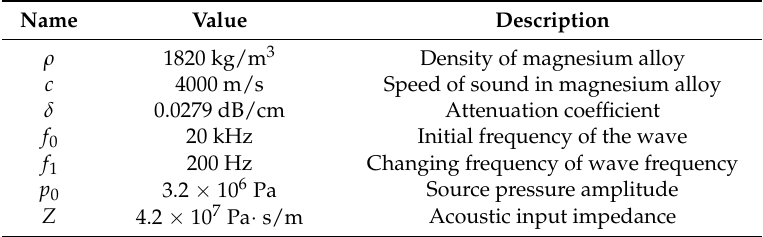
Table 2. Material properties and some critical model parameters.